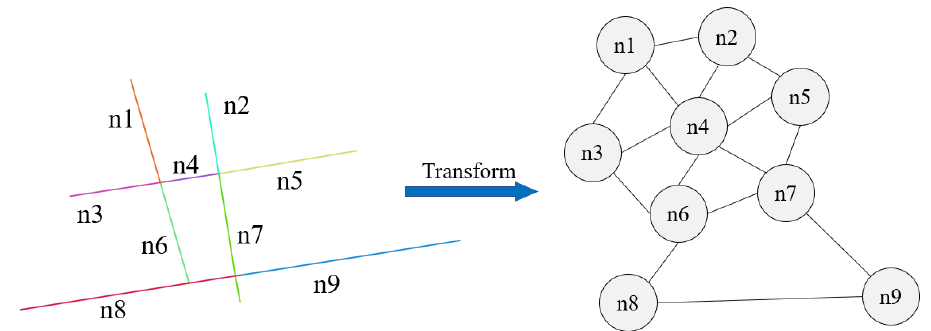
Figure 4. Graph representation of road network. Basic road units are the nodes of graph. Spatial reachability is the edges of graph. The number of traffic violations on the basic road unit is the predicted target value of every node.